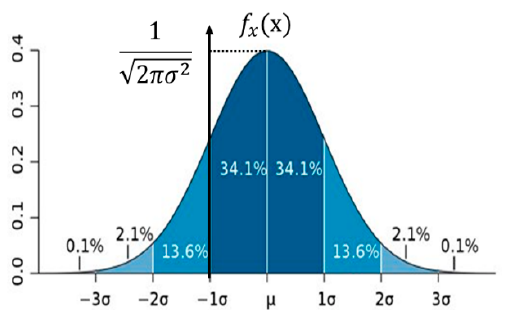
Table 2. Frequency bands for the period of load fluctuation.